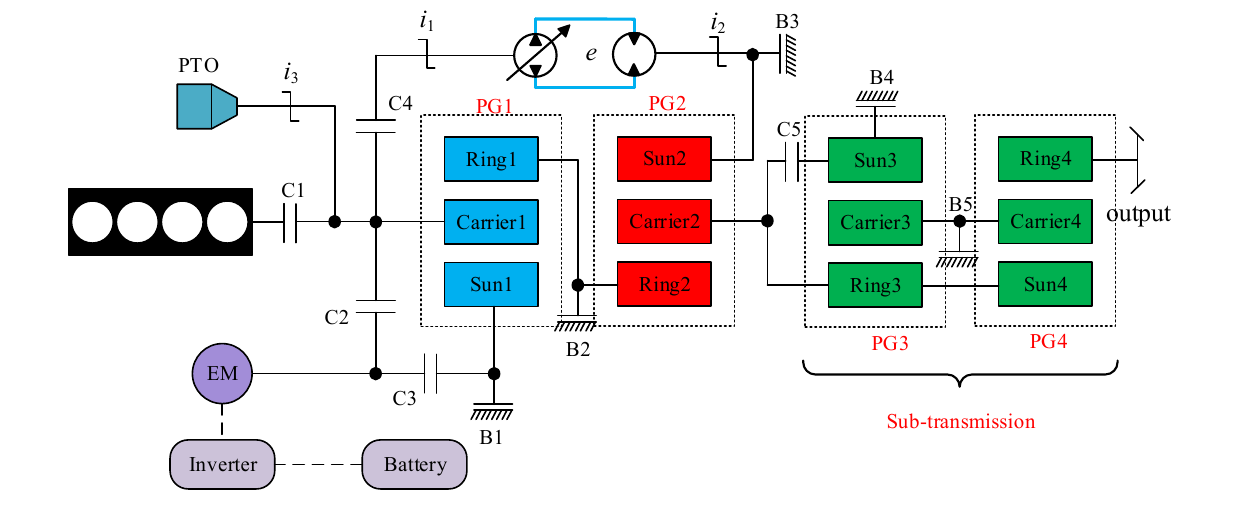
Figure 1. Configuration Scheme. Table 1. Element engagement status of each driving mode.